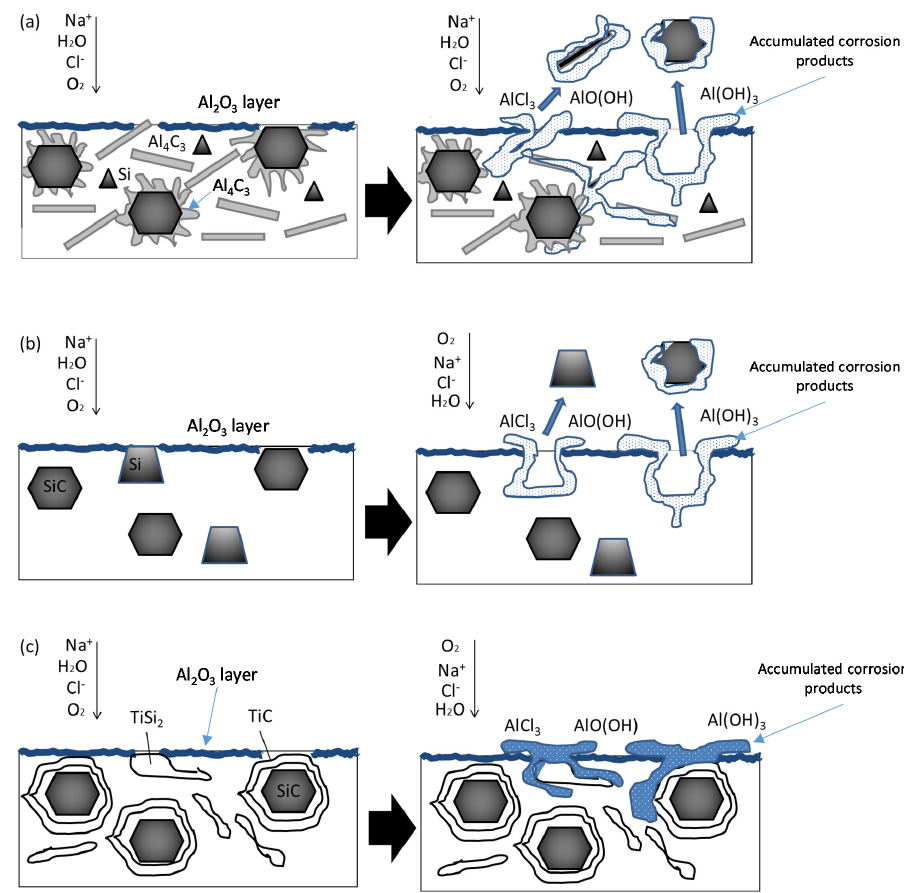
Figure 8. Corrosion mechanisms scheme in the surface of the different coatings: ( a ) Al12Si/SiC; ( b ) Al40Si/SiC; ( c ) Al12Si-Ti/SiC coating surface.